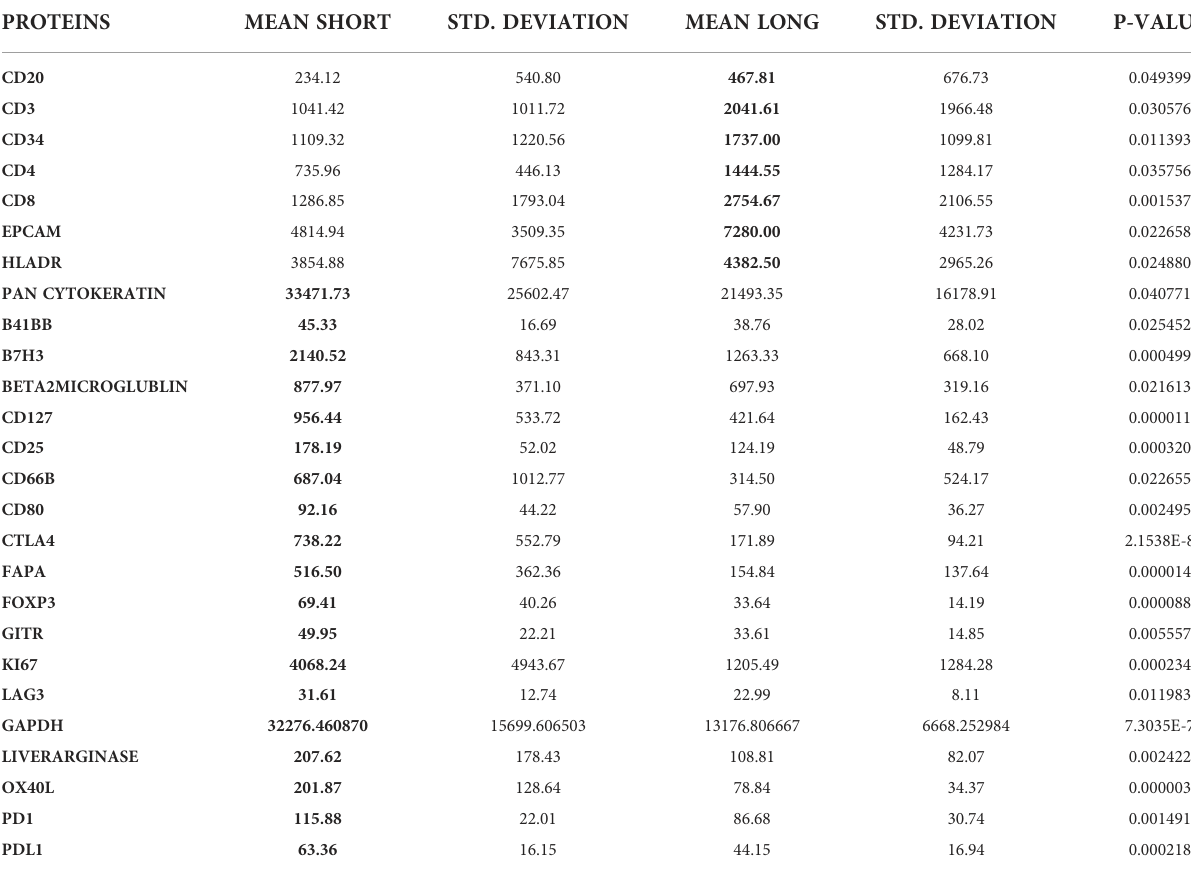
TABLE 1 Comparison of tumor ROIs in the short-term (23) vs. long-term (30) survival group. PROTEINS MEAN SHORT STD. DEVIATION MEAN LONG STD.